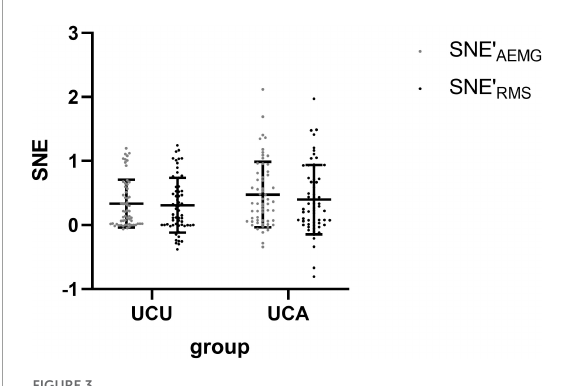
FIGURE3 The comparison (means with standard deviations in parentheses) of the SNE (cid:48) AEMG and SNE (cid:48) RMS of the bilateral biceps brachii during unilateral contraction tasks. SNE (cid:48) AEMG = Log (SNE AEMG + 1), OF (cid:48) RMS = Log (OF RMS +